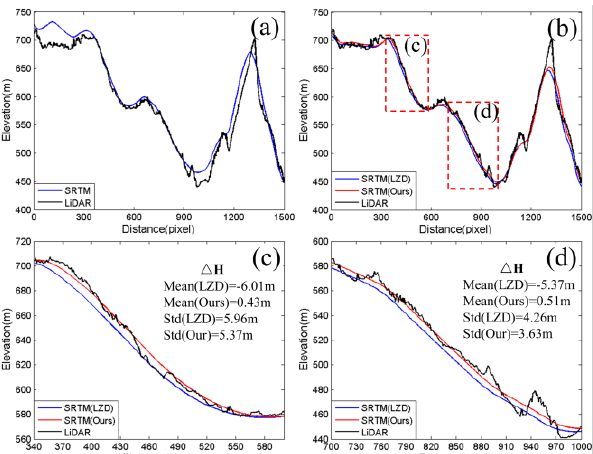
Figure 8. Height profiles along line AA’ shown in Figure 5(a): (a) before coregistration, (b) after coregistration (LZD and our method), (c) and (d) are two enlarged figures from Figure (b).